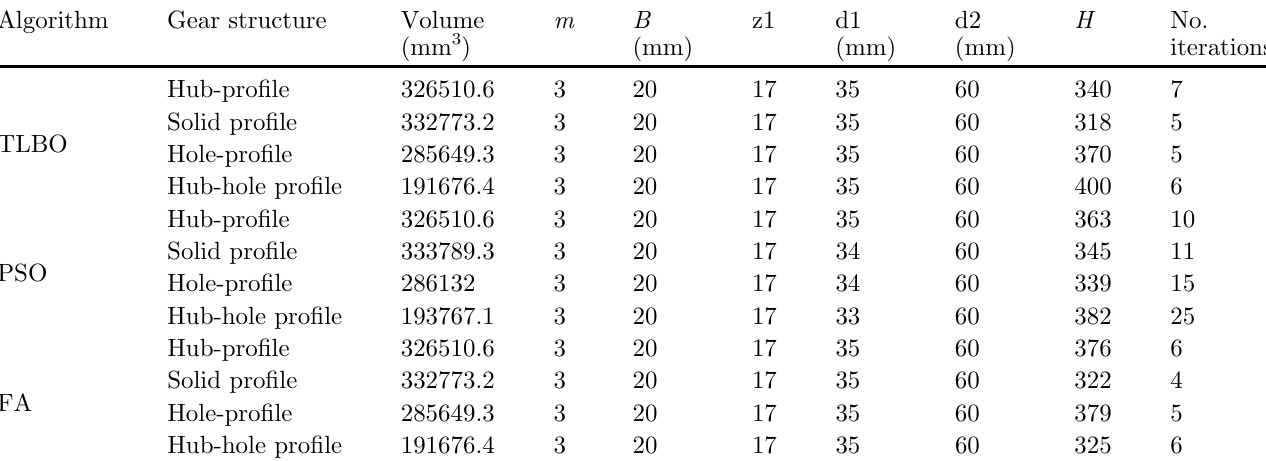
Table 2. Optimal results. Algorithm